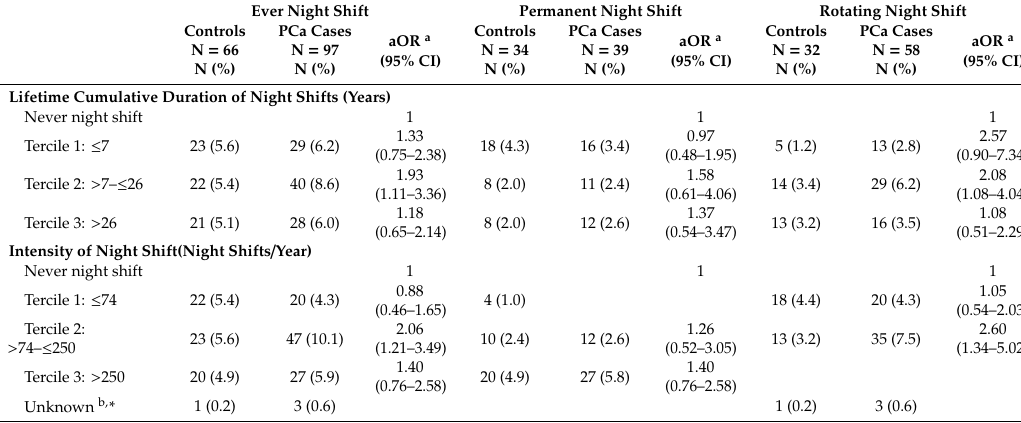
Table 3. Associations between night work indicators and PCa risk according to the type of night shift